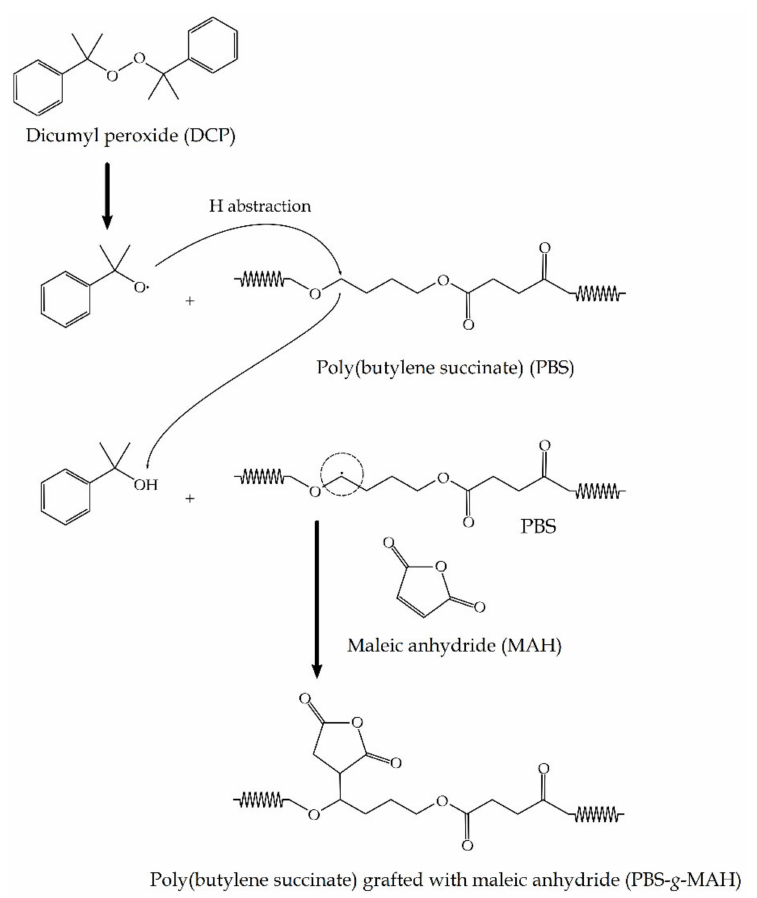
Figure 12. Reaction mechanism to obtain poly(butylene succinate) grafted with maleic anhydride (PBS- g -MAH) from poly(butylene succinate) (PBS) and maleic anhydride (MAH) induced by the presence of dicumyl peroxide